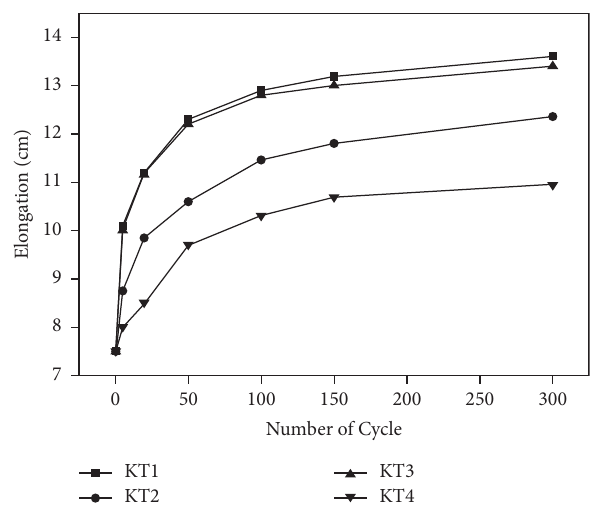
Figure 10: Elongation behavior of therapeutic tapes under 50 °